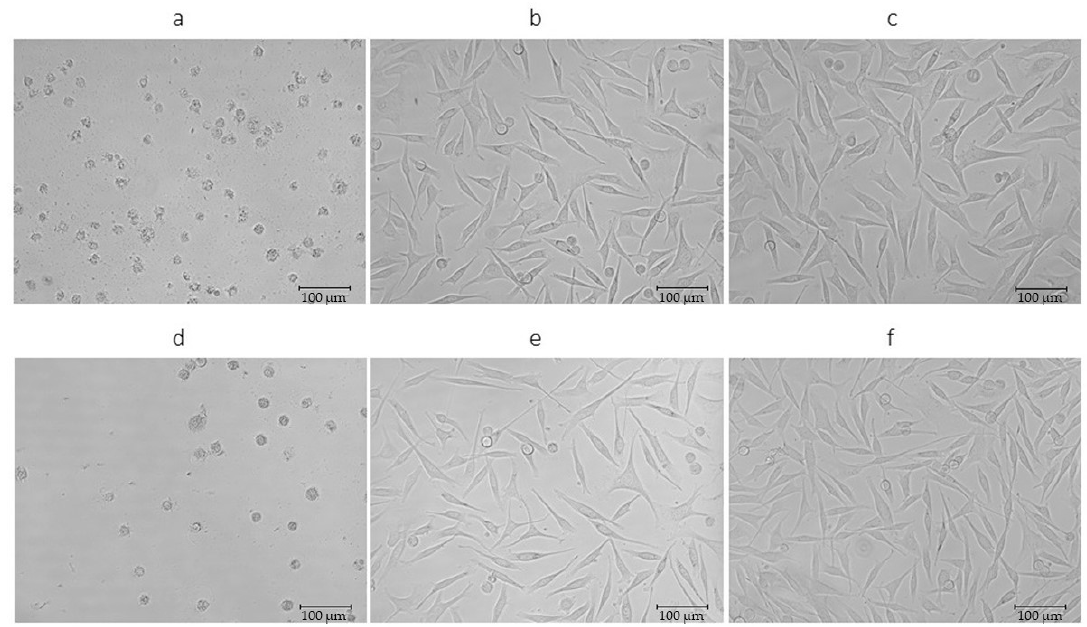
Figure 4. Morphology of WM-266-4 cells exposed to extract x 37 . ( a ) The response of melanoma cells upon application of 1 mg/mL concentration of SFE extract at 300 bar and 60 °C. ( b ) The response of melanoma cells upon application of 0.1 mg/mL concentration of SFE extract at 300 bar and 60 °C. ( d ) The response of melanoma cells upon application of 1 mg/mL concentration of UE extract. ( e ) The response of melanoma cells upon application of 1 mg/mL concentration of UE extract. ( c , f ) represent the control. Magnification 200×.